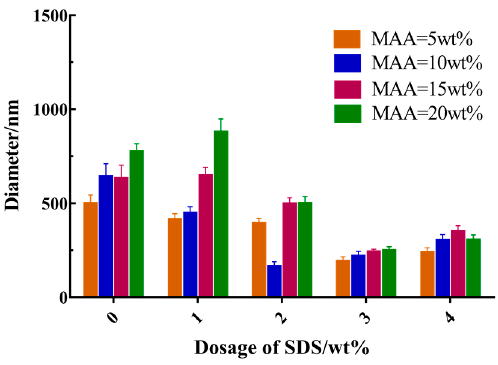
ff ect of reaction parameters on the diameter of the hollow Figure 3. Effect of reaction parameters on the diameter of the hollow microspheres. Figure 3. E